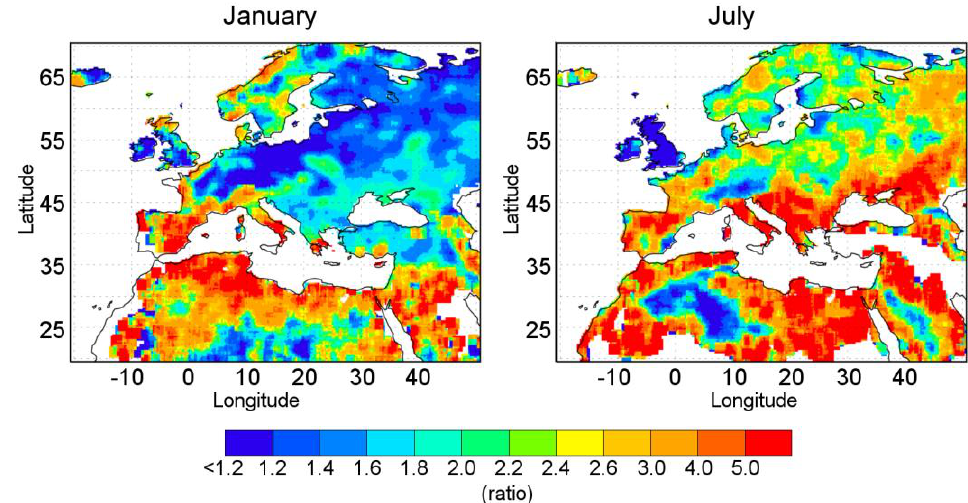
Figure 7. Ratio between the mean values of the observed five years with highest values of E − P < 0, calculated using FLEXPART (PFLEX-extreme), and the mean climatological values of E − P < 0 (PFLEX-Cli) during January (right panel) and July (left panel), which is calculated for each grid point. Period: 1980–2016. White areas over the continent indicate where the PFLEX-Cli does not report values.